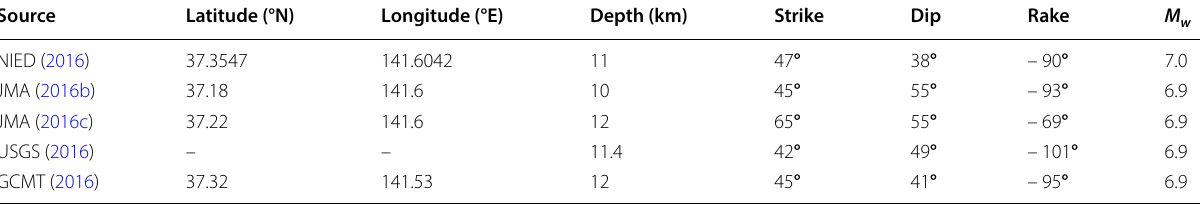
Table 1 East-dipping CMT solutions for the 22 November 2016 event from various institutions Source